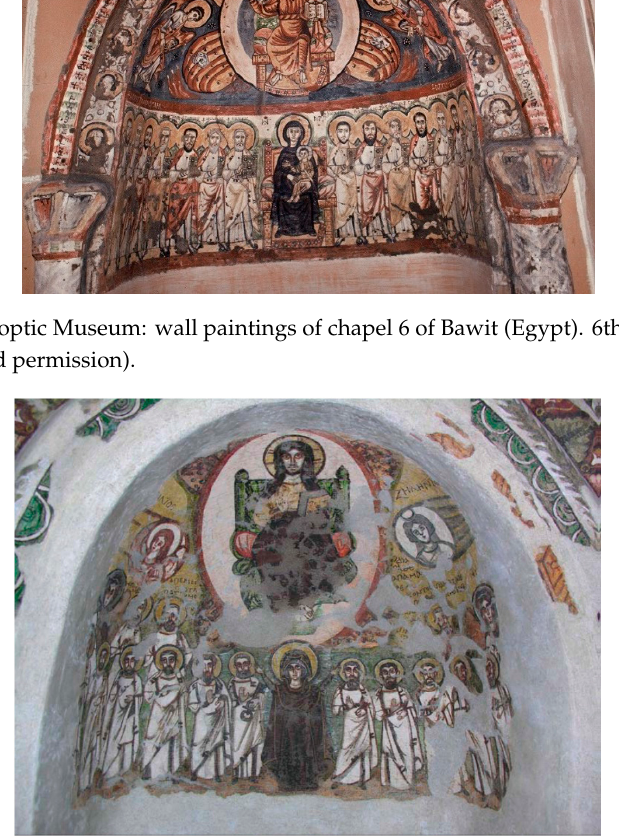
Figure 16. Bawit (Egypt), apse of salle 20, at the present in the Coptic Museum, Inv. No 8012. (with kind permission).